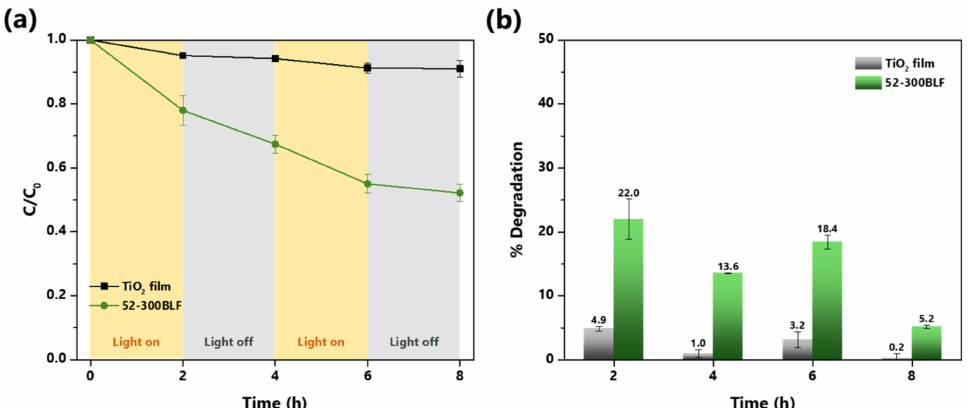
Figure 6. Degradation by: ( a ) relative concentration over time and ( b ) percentage over time of TiO 2 film and